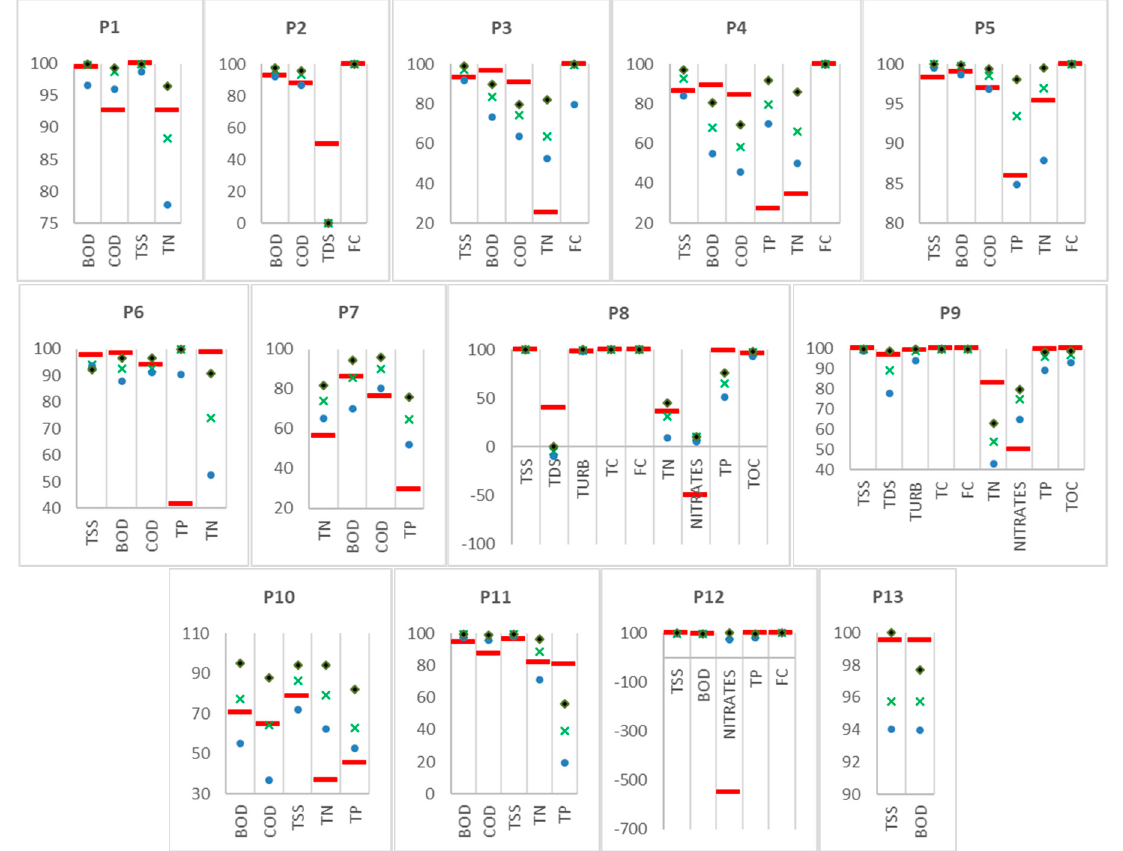
Figure 7. Plausibility check of the 13 simulations P1–13 results. The y -axis shows pollutant removal efficiencies (%) for the literature value ( ) and for the DST simulation operating under minimal ( ), average ( ) and maximal ( ) unit processes efficiencies.